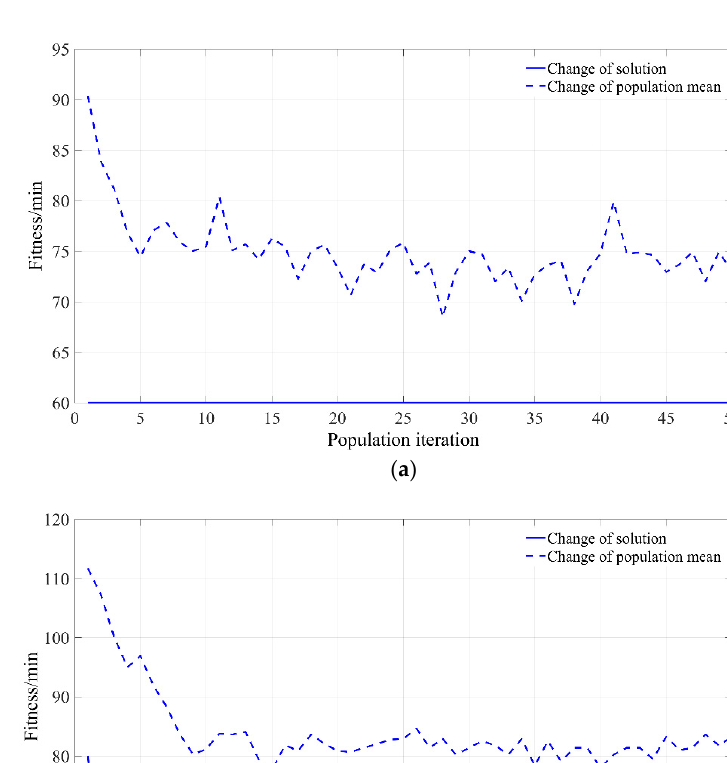
( d ) Figure 10. Change of population fitness value. ( a ) 3 aircraft, ( b ) 4 aircraft, ( c ) 5 aircraft, ( d ) 6 aircraft. ( a )